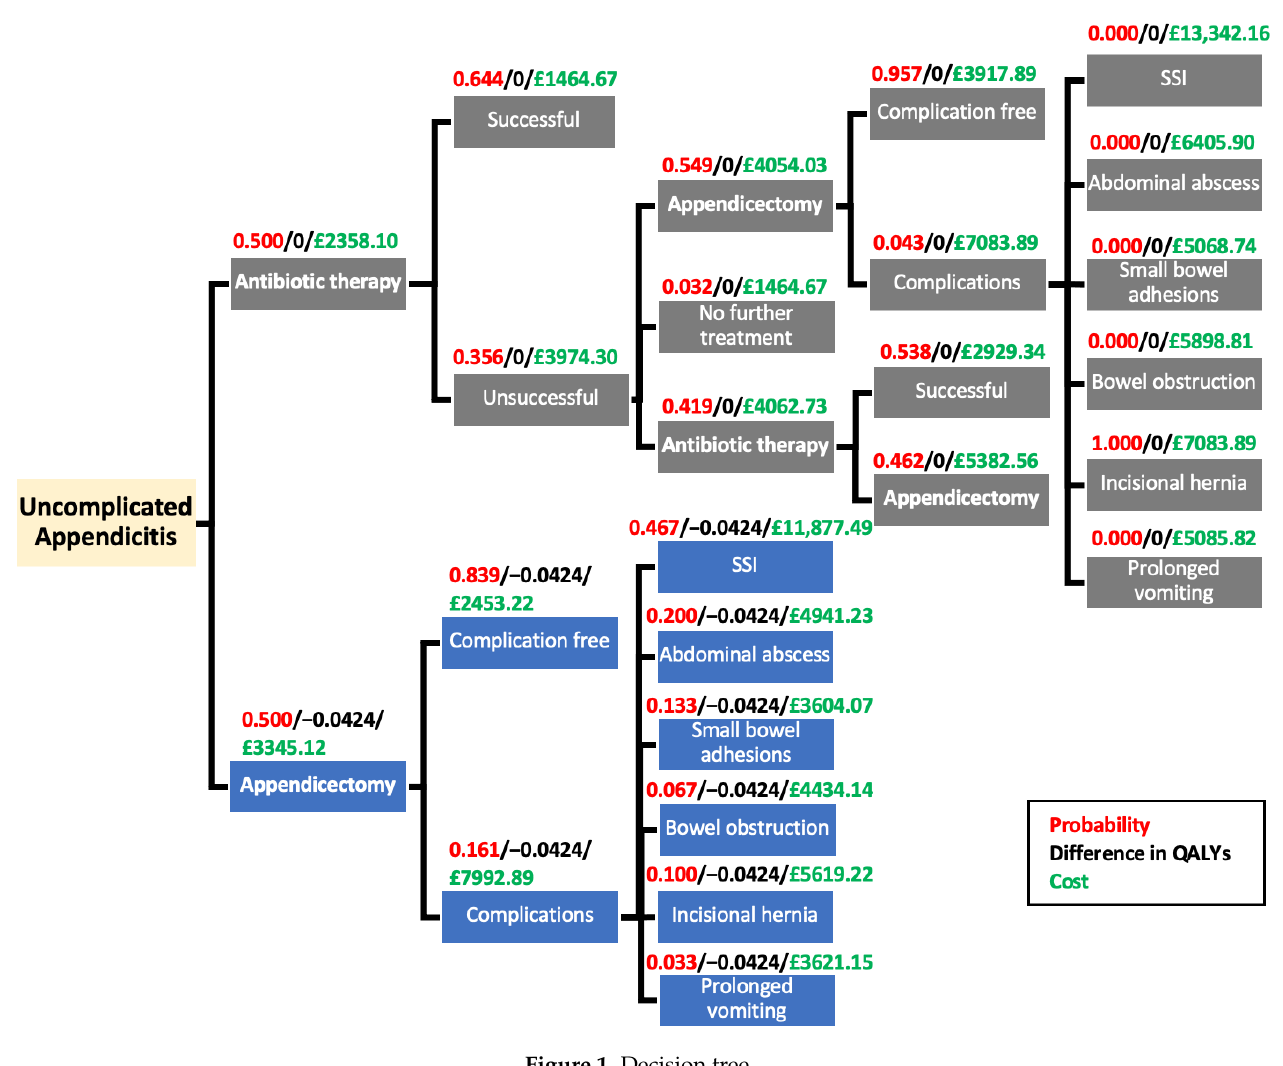
Figure 1. Decision tree.